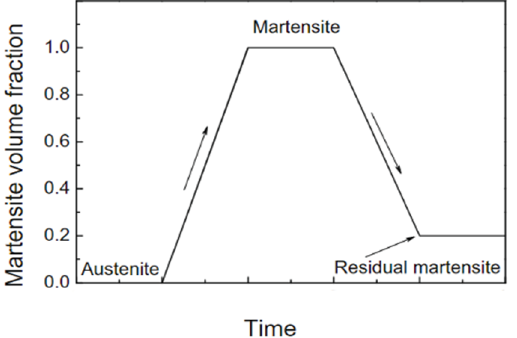
Figure 4. The evolution of martensite during mechanical loading and unloading in the first cycle [39].